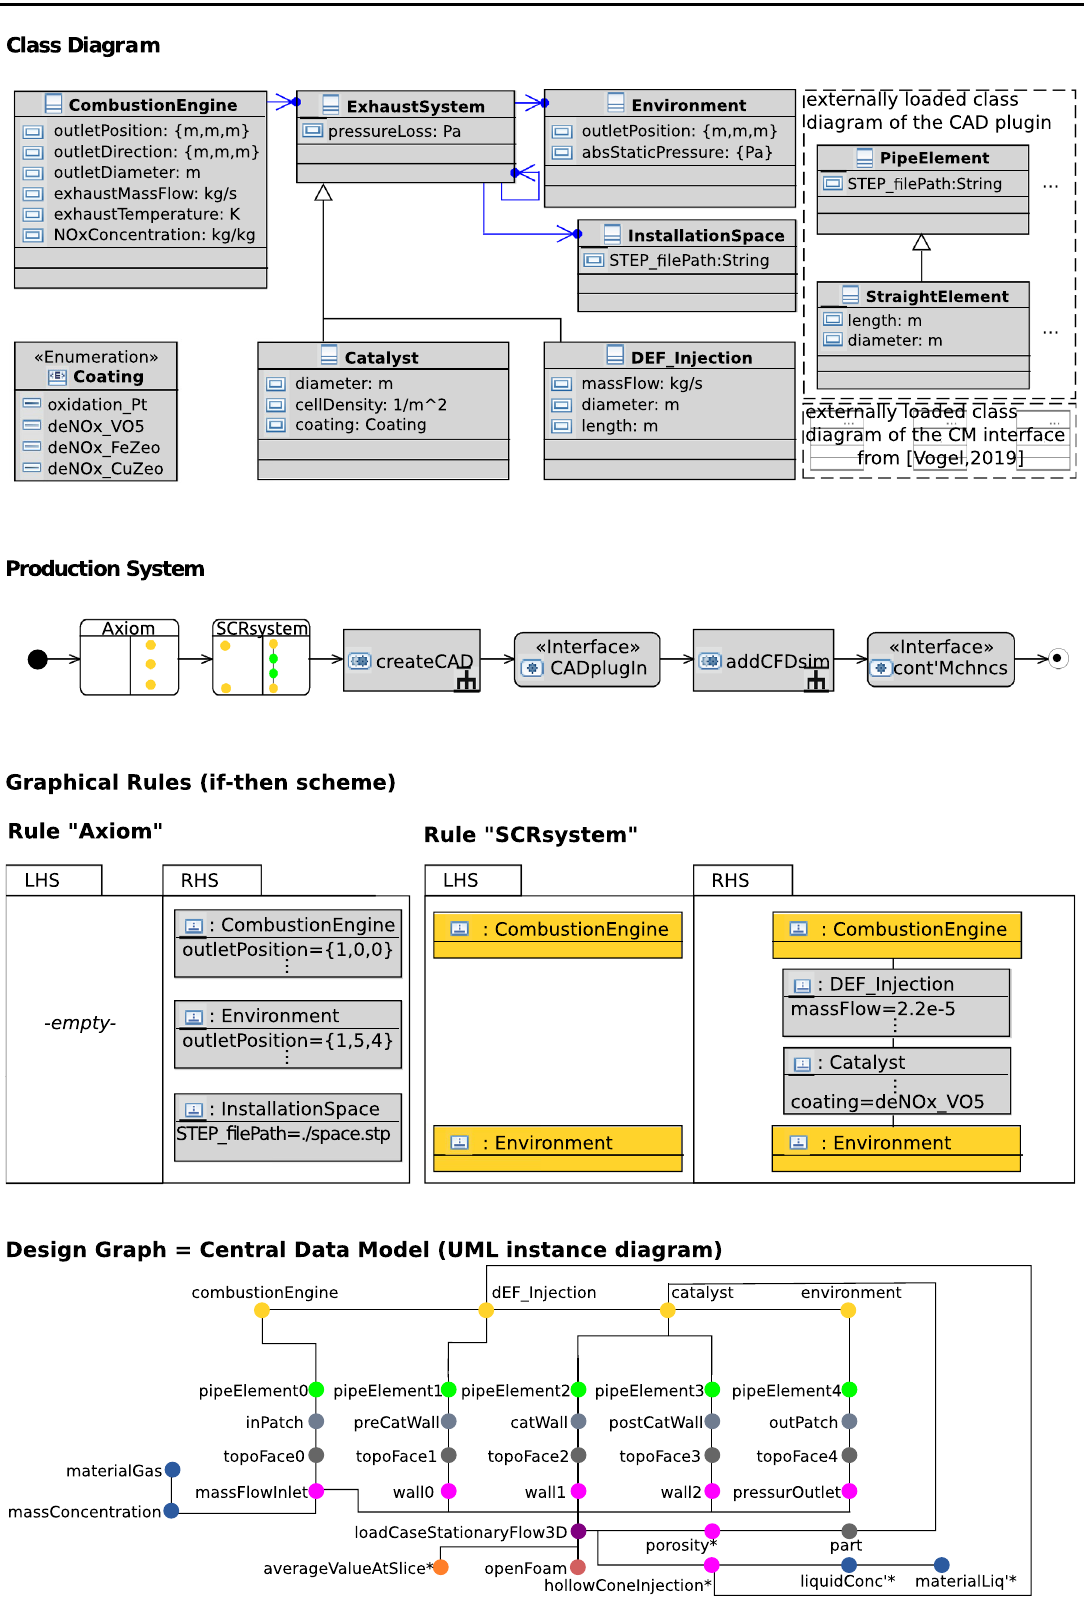
Fig. 11 Case study: Simplified graph-based design language to create the CAD and CFD model of a SCR exhaust aftertreatment system. The schematically shown approach follows the ’classic’ design languages style without class methods and